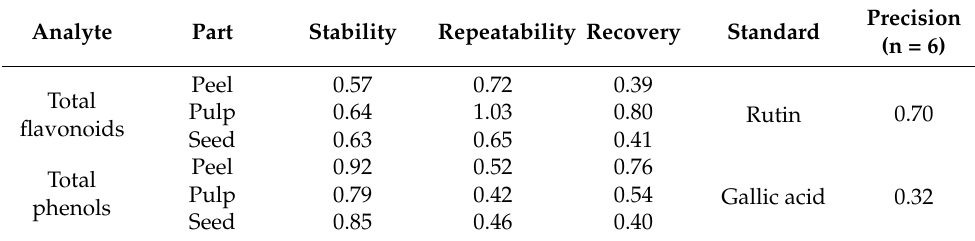
Table 2. The RSD values (%) of methodological evaluation.